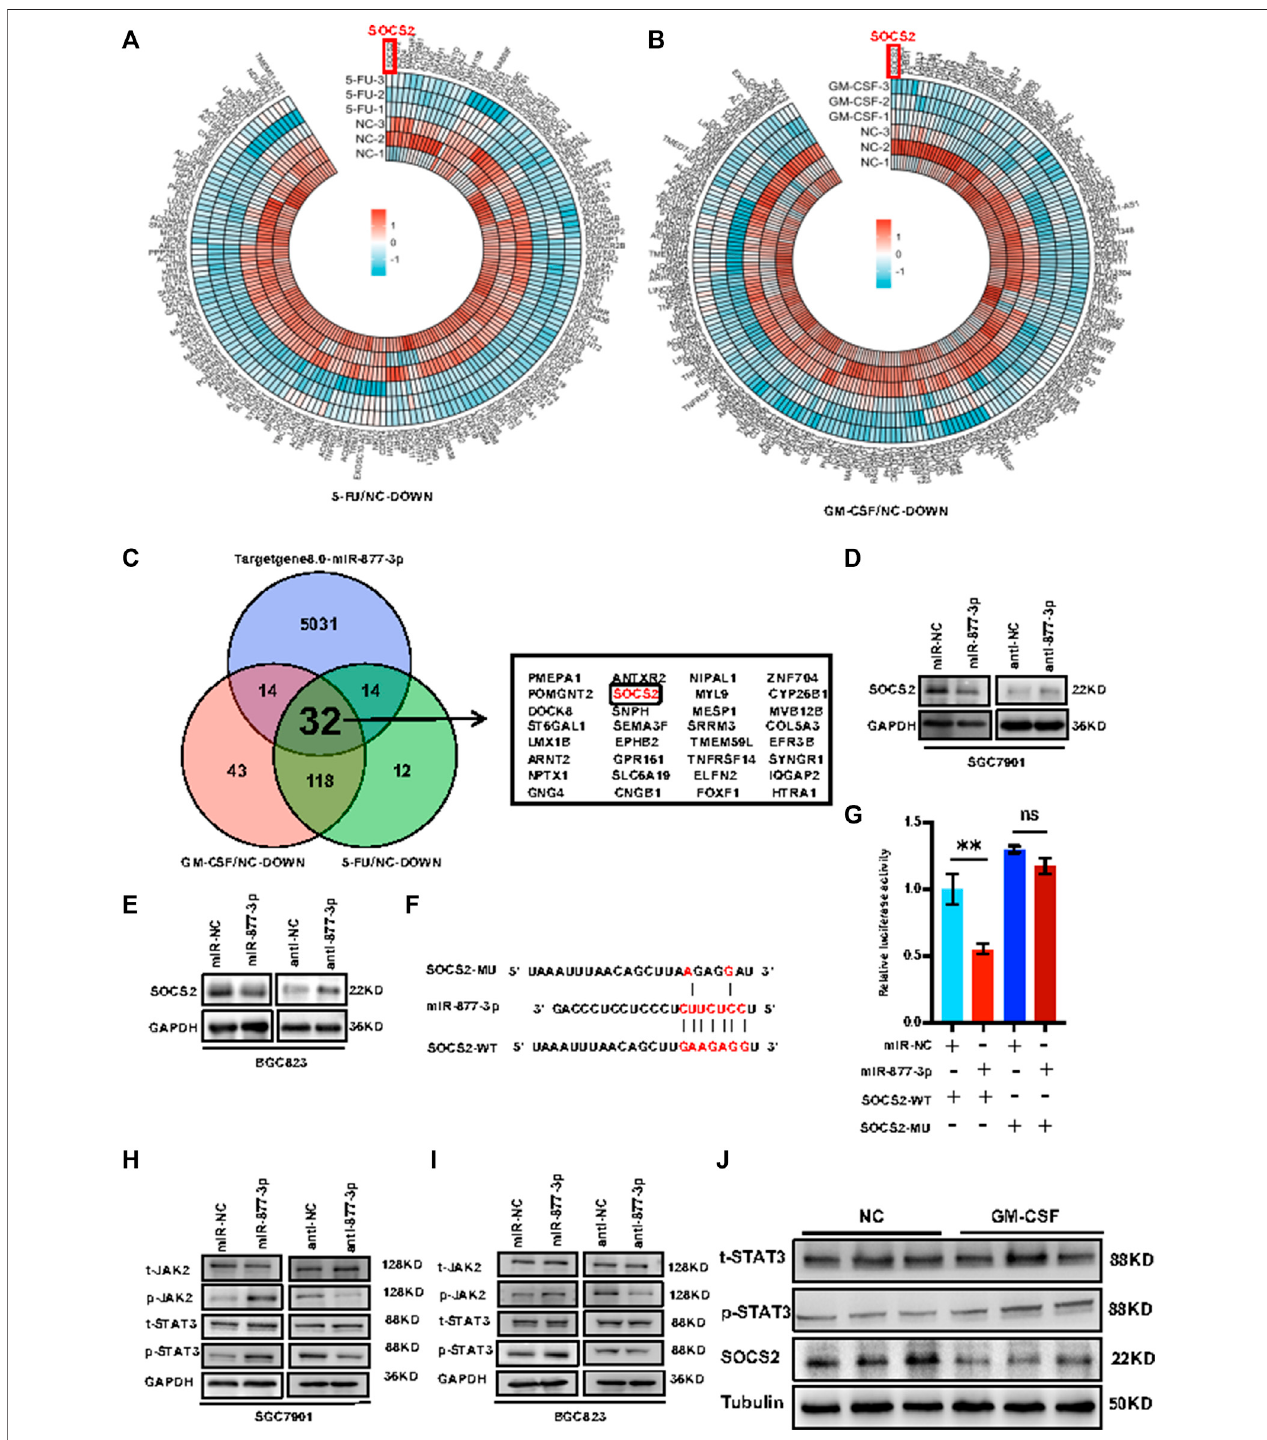
FIGURE 5 | miR-877-3p activated Jak2/Stat3 signaling through targeting SOCS2 in gastric cancer. (A,B) : RNA-seq analysis of the SGC7901 cells with or without stimulationwith5-FU (A) or GM-CSF (B) identi fi edalistofdifferentiallyexpressed downregulatedgenes. (C) :32geneswereoverlappedfromthe176downregulatedgenes by 5-FU treatment, 207 downregulated genes by GM-CSF treatment, and 5,091 potential target genes of miR-877-3p predicted by TargetScan Human8.0, including SOCS2 . (D,E) : Western blot demonstrated inhibition of SOCS2 by miR-877-3p overexpression and promotion of SOCS2 by miR-877-3p knockdown in both SGC7901 and BGC823 cells. (F) : Sequence alignment of wide type (WT) or miR-877-3p -binding sites-mutated (MU) 3 ′ UTR of SOCS2 . (G) : luciferase reporter assay demonstratedinhibitionofWT- SOCS2 -3 ′ UTRby miR-877-3p ,butnotMU- SOCS2 -3 ′ UTR. (H,I) :Westernblotdemonstratedpositiveornegativeregulationof p-Jak2 and p- Stat3 by overexpression or knockdown of miR-877-3p in both SGC7901 and BGC823 cells. (J) : Western blot demonstrated downregulation of SOCS2 and activation of Jak2/Stat3 signaling by GM-CSF treatment in the tumors from the mice model. Data are presented as the mean ± SEM ( N = 3). * p < 0.05, ** p < 0.01, *** p < 0.001.